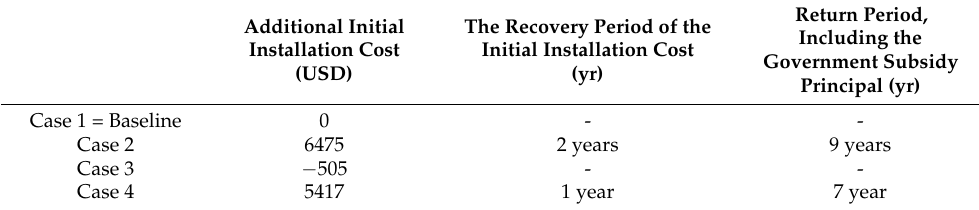
Table 7. Case-wise construction cost recovery period with energy